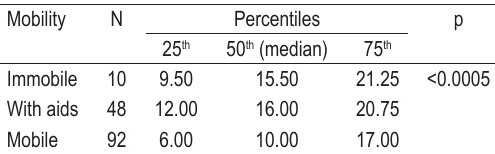
TABLE 3. Relationship between geriatric depression scale and mobility of residents